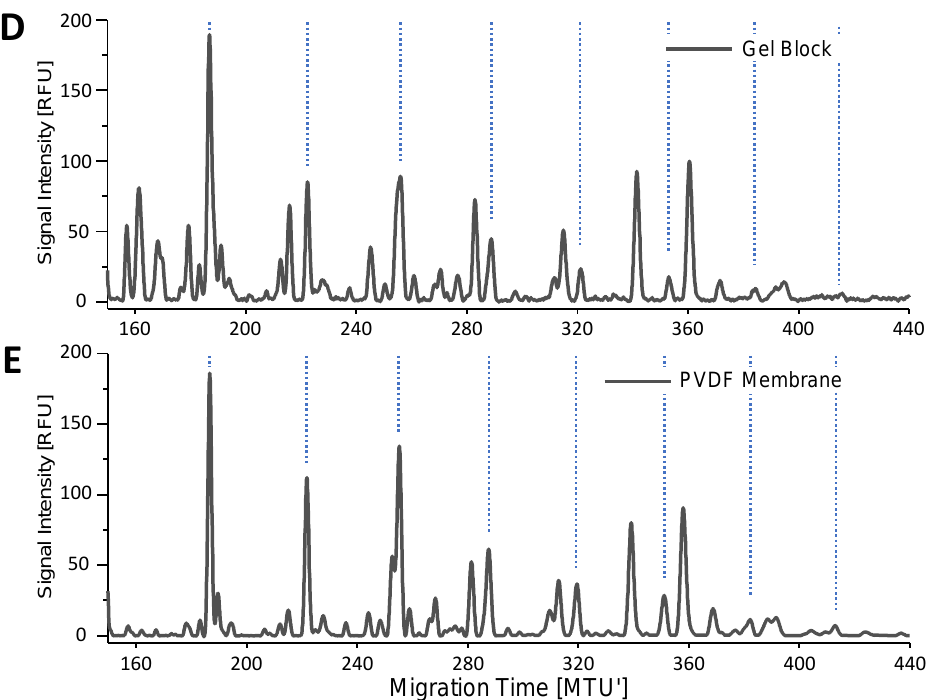
Figure 1. xCGE-LIF analysis of APTS-labeled N -glycans from human embryonic stem cells (hESCs) without purification ( A ) and a maltodextrin standard to identify signals related to OSIs ( B ). The hESCs were purified on the (glyco-) protein level prior to N -glycan release by the following methods: filtration using 10 kDa molecular weight cut-off filter ( C ), incorporation of sample into gel block ( D ), and immobilization of glycoproteins on PVDF membrane ( E ). X -axis was aligned to an internal migration time standard, resulting in Migration Time Units (MTU’). Signal intensity is displayed in relative fluorescence units (RFU). Data analysis was performed using